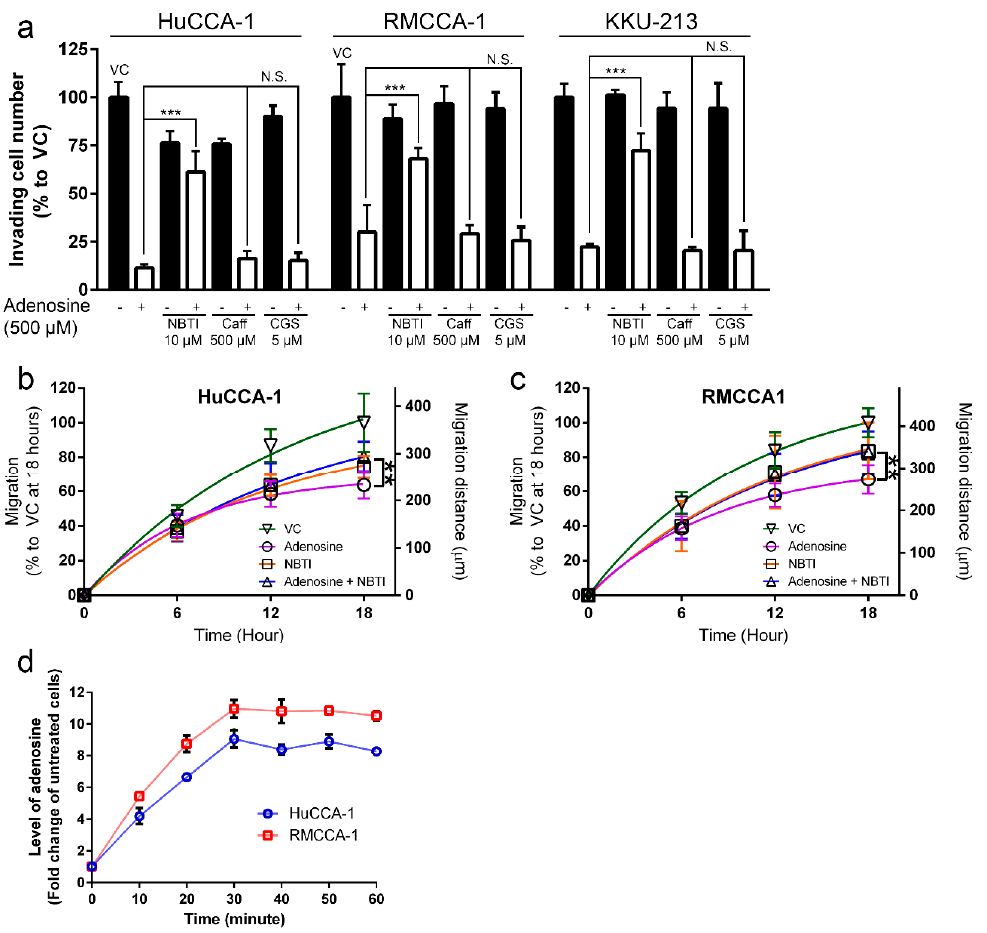
Figure 4. Adenosine inhibited cholangiocarcinoma (CCA) cell motility in a receptor-independent mechanism. ( a ) Adenosine suppressed CCA cell invasion through Matrigel in a